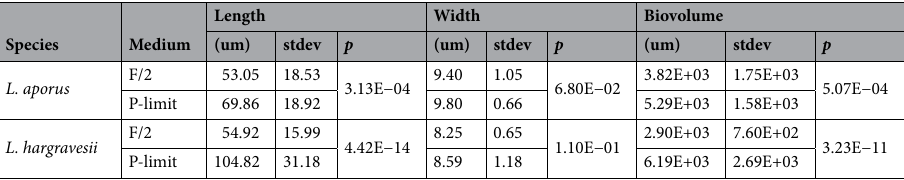
Table 2. Morphometric parameters of L. aporus and L. hargravesii : length and width of cells shown in µm and cell biovolume in µm 3 .